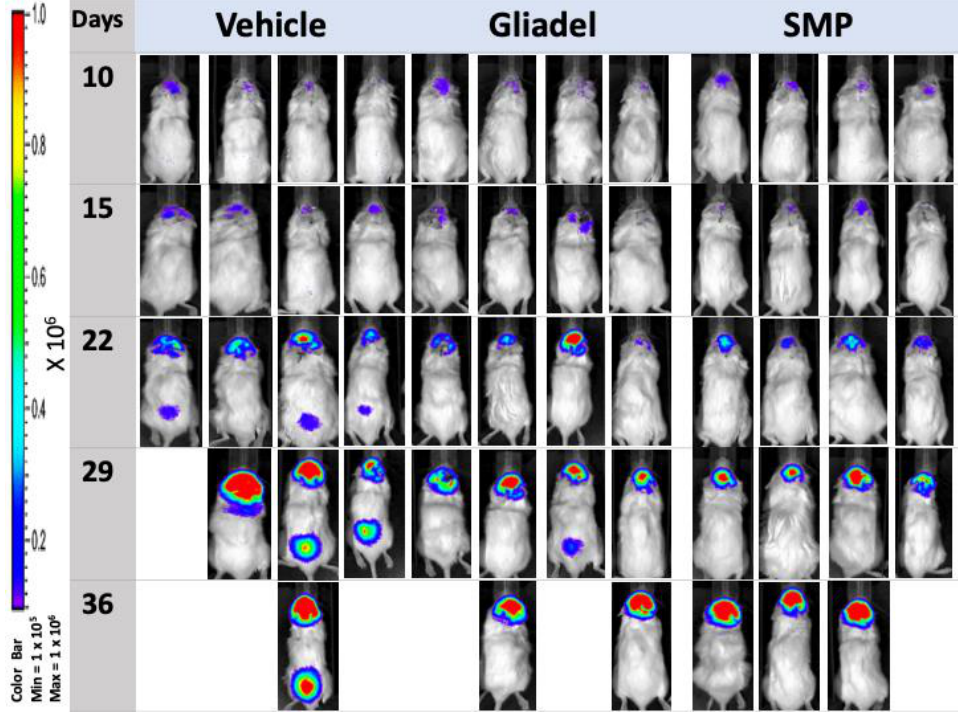
Figure 5. IVIS images of mice bearing U87-TR xenografts. Representative bioluminescent images of mice bearing U87-TR xeno- grafts were taken on days 10, 15, 22, 29, and 36 following treatment with TMZ vehicle, TMZ-combined Gliadel, or TMZ-combined SMPs.